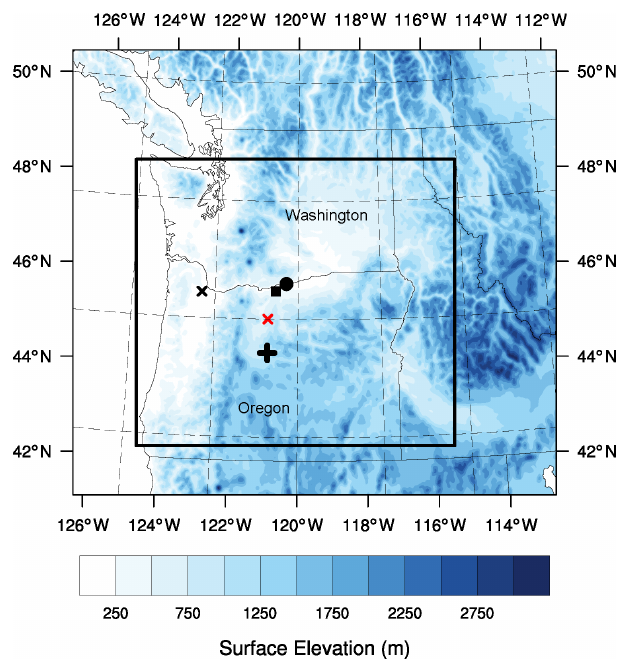
Figure 2. WRF modeling domains. The rectangle denotes the area of the 750m domain. US state boundaries are indicated. The black x denotes the location of Troutdale; the cross denotes Prineville; the square denotes Wasco and Van Gilder Road; the circle denotes the location of the wind farm in the area; and the red x denotes the location in the WRF domain where profiles are plotted in Fig. 5. The Columbia River cuts through the Cascade Range at the border between the state of Oregon to the south and Washington to the